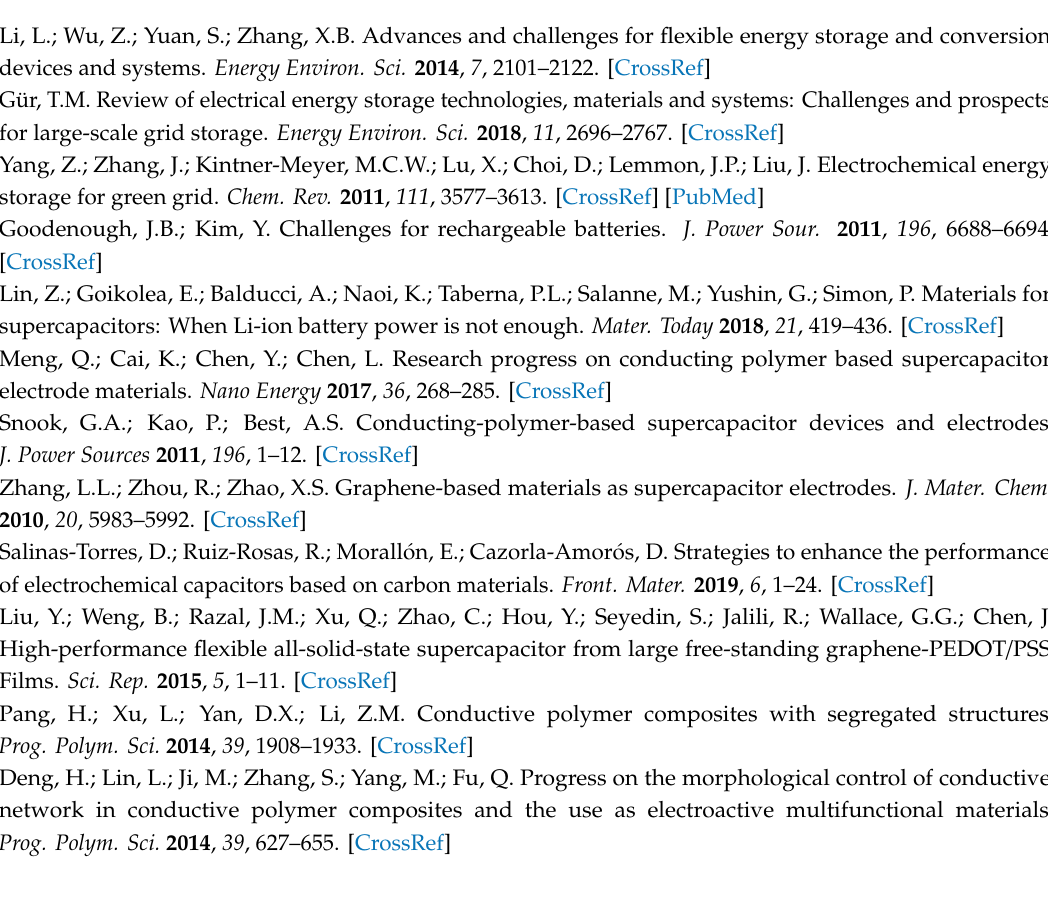
Figure S1: SEM images of (a) CAC and (b) KAC; Table S1: C(1s), O(1s) and S(2p) XPS spectra of overall